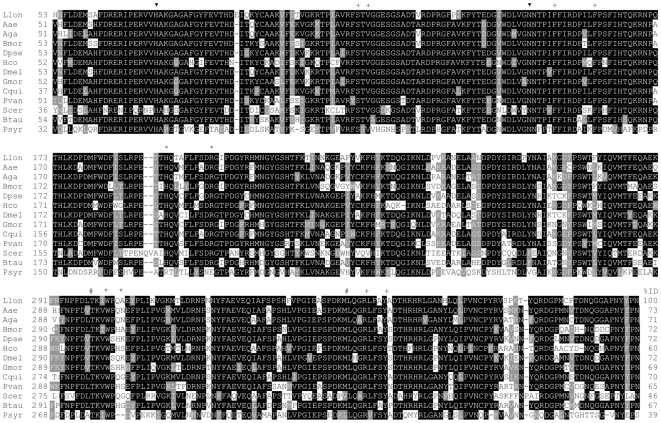
Amino acid sequence alignment of selected catalases.Sequences were retrieved from GenBank (GB), Protein Data Bank (PDB) or from Peroxibase (PB). The listed proteins are respectively from Lutzomyia longipalpis (GB:ABV60342.1), Aedes aegypti (PB:5267), Anopheles gambiae (PB:5269), Bombyx mori (PB:5266), Drosophila pseudoobscura (PB:5273), Haemonchus contortus (PB:5270), D. melanogaster (GB:NP_536731.1), Glossina morsitans morsitans (GB:ADD20421.1), Culex quinquefasciatus (GB:XP_001848573.1), Penaeus vannamei (PB:5278), Saccharomyces cerevisiae (PDB:1A4E), Bos taurus (PDB:8CAT), Pseudomonas syringae (PDB:1M7S). Conserved residues in catalases are with black background, consensus alternatives are shaded. The symbols ▾, +, and * mark catalytic, heme binding and NADPH binding residues, respectively. The symbol # mark residues that define heme orientation. All sequences are from clade 3 of monofunctional catalases, with the exception of Psyr, which is a clade 2 enzyme. In catalases from clade 2 (Psyr numbering), heme orientation (His-IV) is defined by residues 301 (never Leu) and 350 (frequently Leu). In catalases from clade 3, these positions are commonly occupied by Leu and non-Leucine residues, respectively. NADPH binding catalases have the signature (Btau numbering) His 193, Arg 202, Val 301 and His 304, which is not present in catalases from clades 1 (not shown) and 2 (Psyr). Insect catalases share some of the NADPH binding residues, but not all. However, catalytic residues and heme binding residues are fully conserved in all sequences.